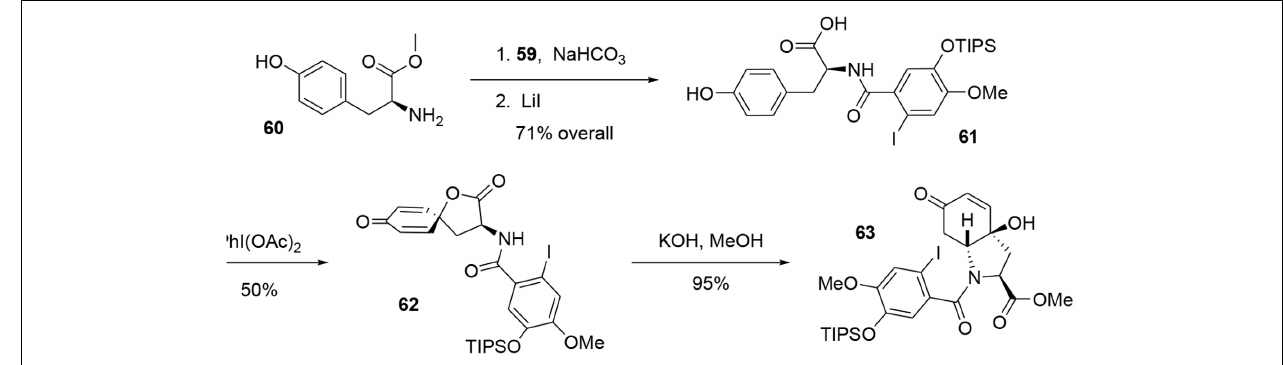
Scheme 17 | Formation of heterocyclic system of fortucine.